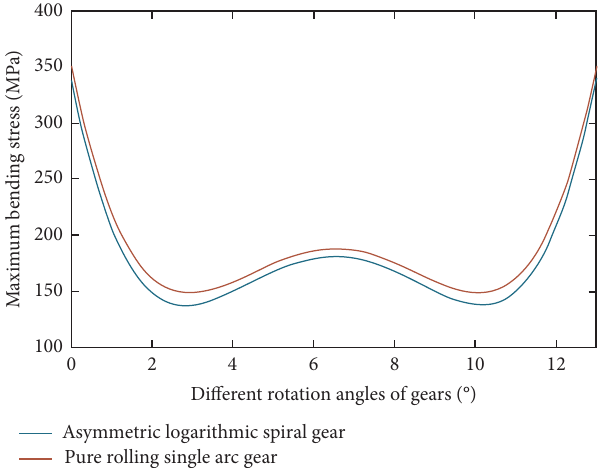
F IGURE 24: Change of the maximum bending stress at different angles of the gears.